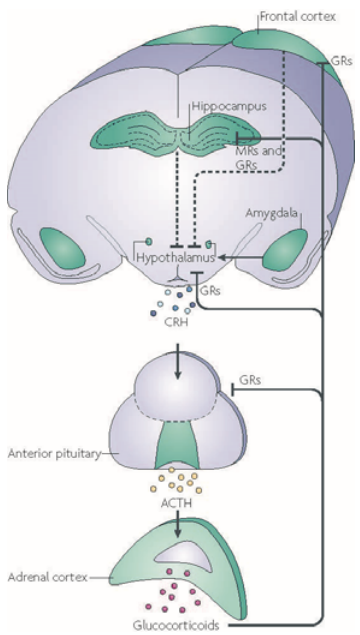
Figure 1. The stress response. Stressful events trigger the release of corticotrophin releasing hormone (CRH) from the hypothalamus which results in the release of adrenocorticotropic hormone (ACTH) from the pituitary into the blood. This causes glucocorticoids to be released from the adrenals which bind to glucocorticoid (GRs) and mineralocorticoid (MRs) receptors creating a negative feedback circuit, ending the stress response and restoring allostasis. Adapted from